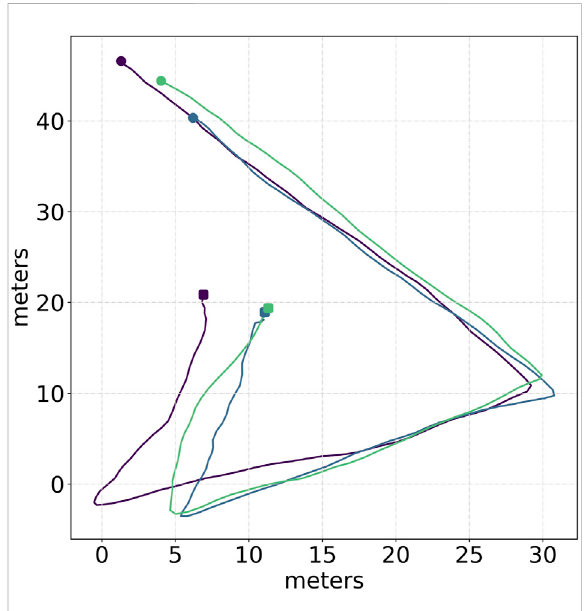
FIGURE 8 Triangle-shaped trajectory performed in real experiments with 7 UAVs equipped with UVDAR sensing technology. The picture shows the trajectory of the center of mass of the swarm over three experiments; different colors are associated with each experiment. A circle represents the starting point, while a triangle represents the endpoint of the trajectory.